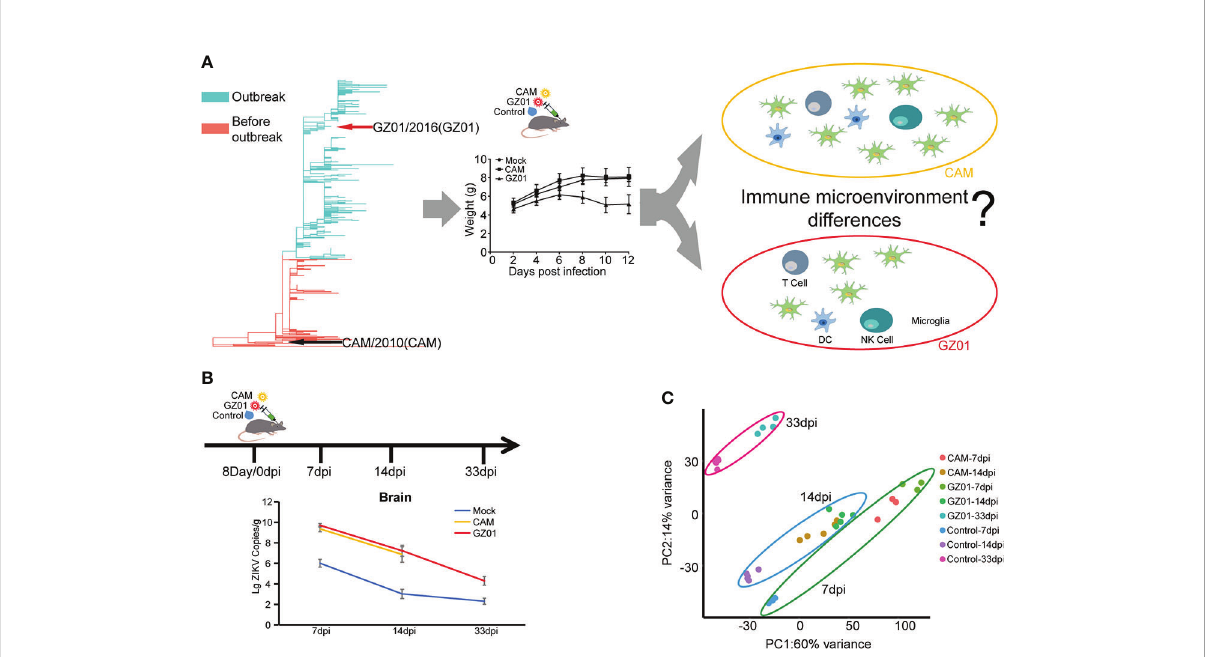
FIGURE 1 Schematics for identifying immune signatures from ZIKV-infected mouse brains. (A) , Different immune response of mice caused by different strains of Zika virus. Two representative ZIKV strains, CAM and GZ01, were selected and are indicated with black and red arrows in the phylogenetic tree. (B) , Experimental proposal for building a mouse model and data analysis. Mice were inoculated with 100 pfu of ZIKV strains or control medium on the eighth day after birth. Brain samples were collected at 7, 14, and 33 dpi for further experiments. Viral loads of ZIKV in mouse brains are shown in line chart. (C) , PCA displaying biological variation among different infection